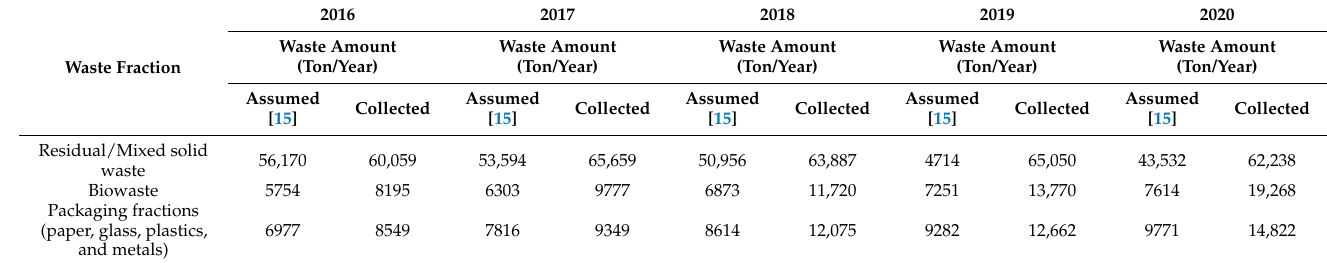
Table 1. The predicted and collected waste amounts from the ZGO Gac